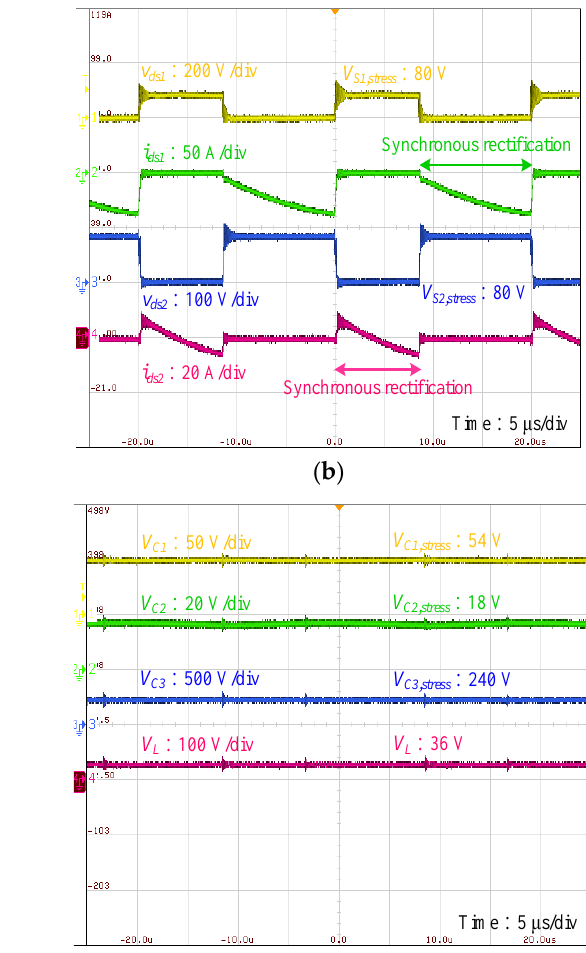
Figure 14. Experimental results of the proposed topology, operated in the step-up mode under the full load (500 W): ( a ) V gs 1 , V gs 2 , i lk 1 , and i lk 2 ; ( b ) V ds and i ds of S1 and S2; ( c ) V ds and i ds of S3 and S4; and ( d ) V C 1 , V C 2 , V C 3 , and V H .